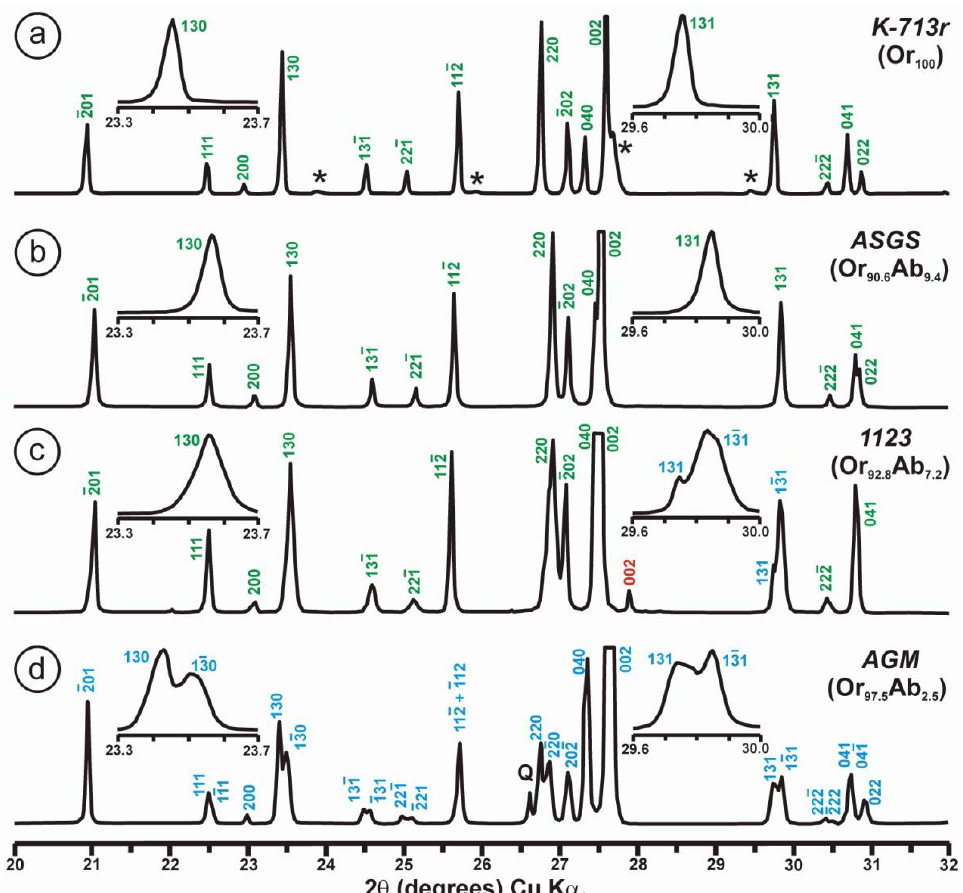
Figure 9. Powder XRD patterns of four specimens of K-rich feldspar between 20 and 32 ◦ 2 θ (CuK α 1 radiation) are shown with (hkl) values of the main Bragg diffraction maxima. Insets show the regions in which the (130)–(130) peak splitting between 23.3 and 23.7 ◦ 2 θ can appear, and the (131)–(131) peak splitting between 29.6 and 30.0 ◦ 2 θ . ( a ) Specimen K-713r (Or100) is an ion-exchanged sample using the Eifel sanidine (Germany) as a starting material (see [4] for details), with (hkl) values in green, corresponding to the sanidine mineral species with C 2/ m symmetry, as in the precursor, and additional peaks (*) from the KBr salt used in the ion-exchange experiment. ( b ) Specimen ASGS (Or 90.6 Ab 9.4 ) from St. Gotthard (Switzerland) has an X-ray pattern typical of orthoclase. ( c ) Specimen 1123 (Or 92.8 Ab 7.2 ) from Valais (Switzerland) has an X-ray pattern mainly consistent with that of orthoclase, i.e., without peak splitting in most of the (hkl), (hk0) and (0kl) maxima, but with a broad (130) peak and a heterogeneous character with visible peak splitting in the (131)–(131), consistent with a triclinic character as in the K-feldspar variety called “X-ray intermediate microcline”. Incipiently exsolved Na-feldspar is detected by the (002) peak in red. ( d ) Specimen AGM (Or 97.5 Ab 2.5 ) from Guanajuato (Mexico) has an X-ray pattern distinct from the previous mineral species; it corresponds to “valencianite”, which shows (hkl) peaks in blue with incipient peak splitting, in comparison with those in “X-ray low microcline”. The experimental details of XRD patterns are in